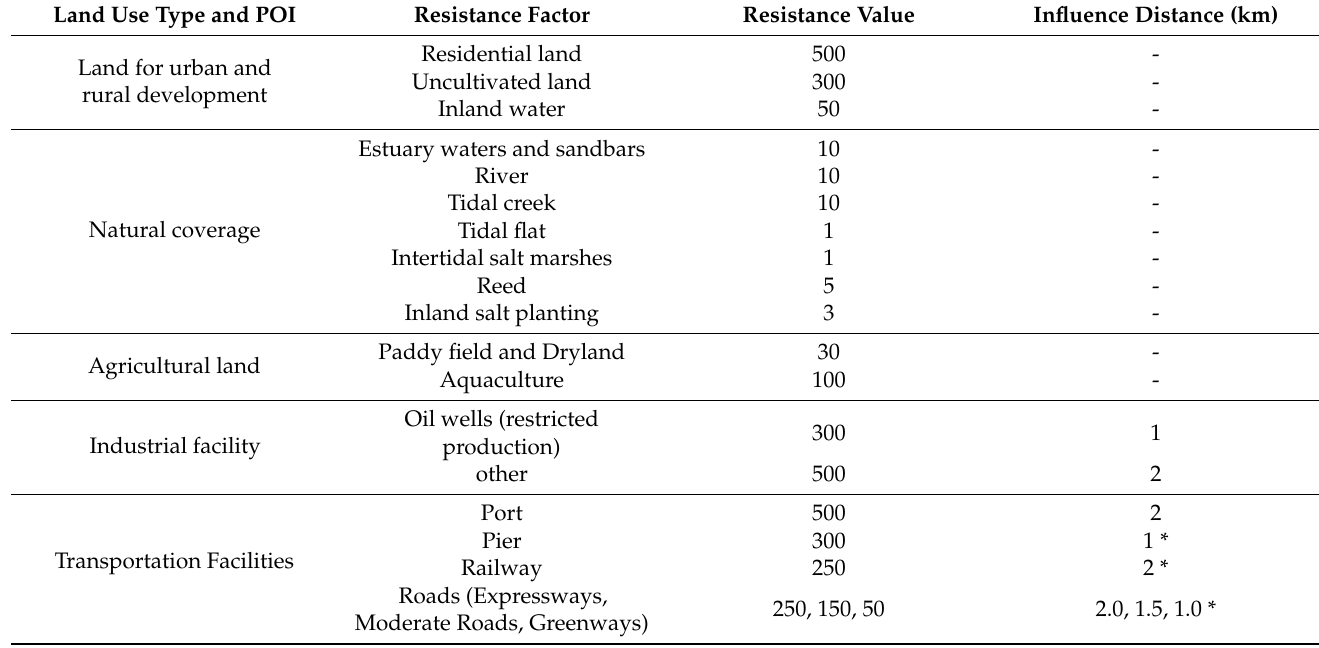
Table 3. Initial resistance